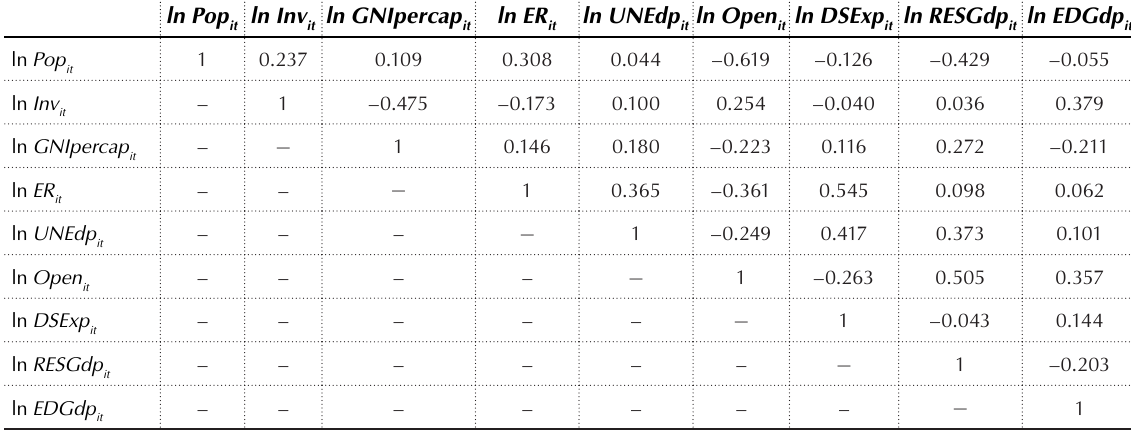
Table 4. Correlation matrix